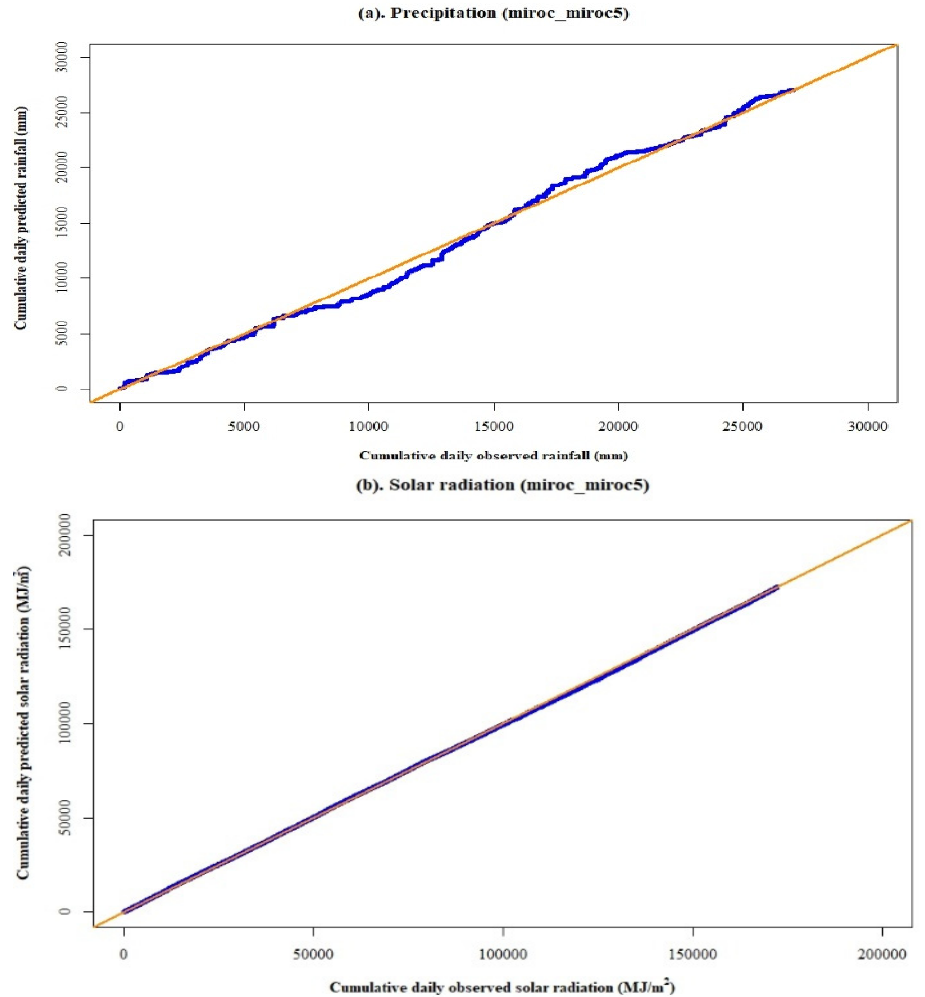
Figure 9. Double mass curve plots for the precipitation and solar radiation data by the model, miroc_miroc5, for the baseline period (1980–2004).